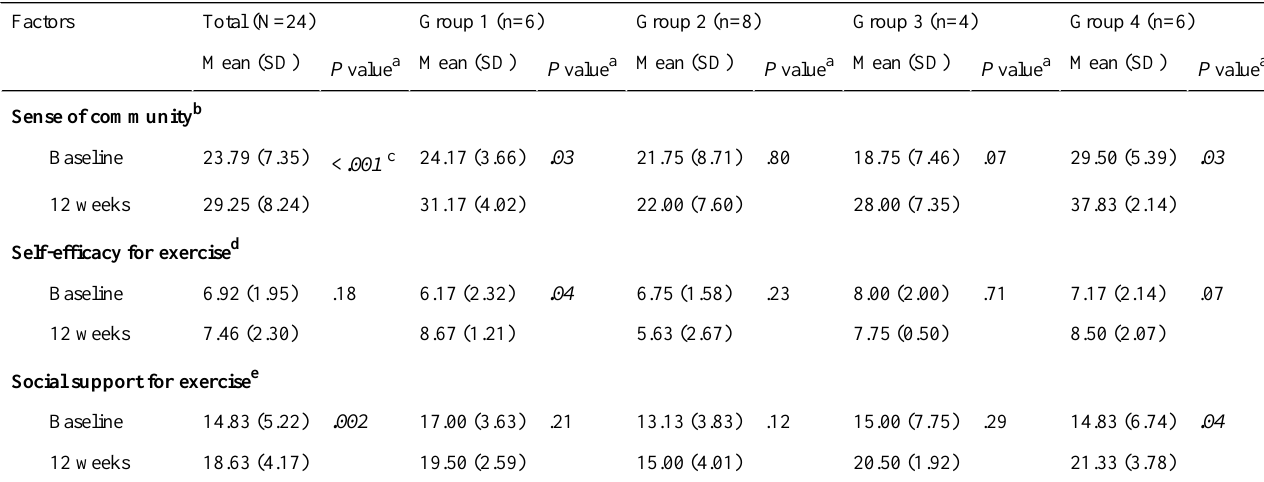
Table 3. Changes in the levels of social-cognitive factors at baseline and 12 weeks.